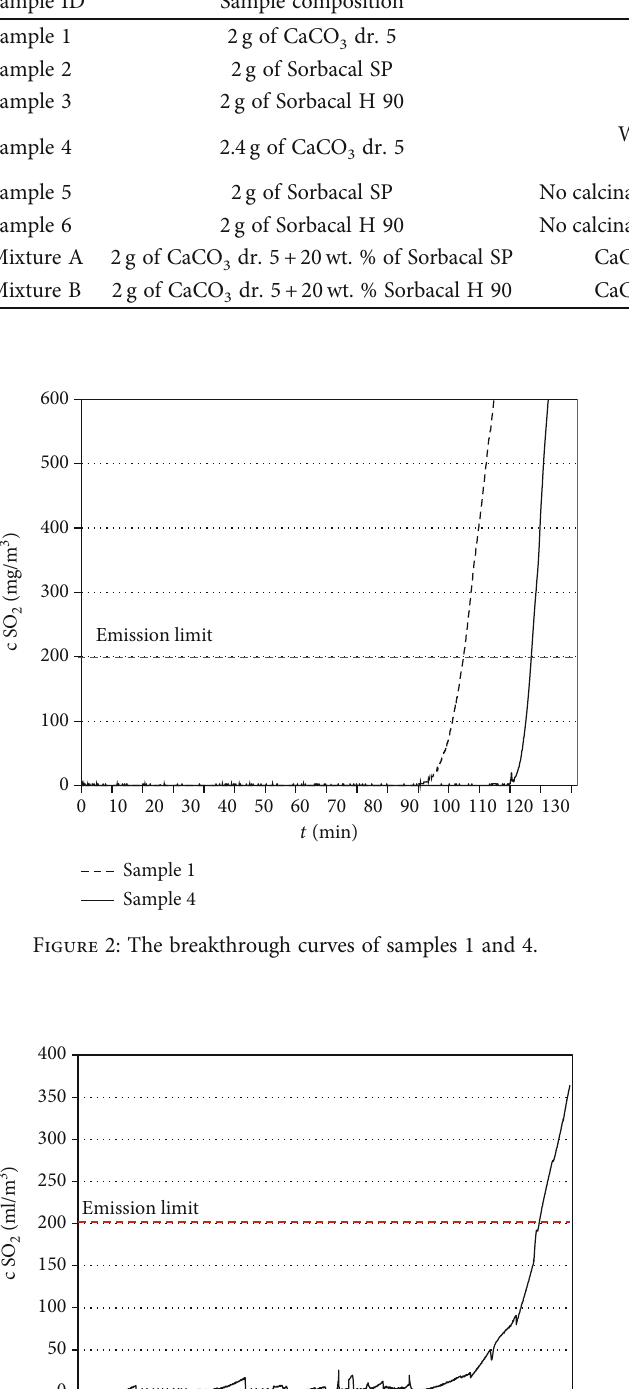
Figure 5: The evaluation and comparison of samples 5 and